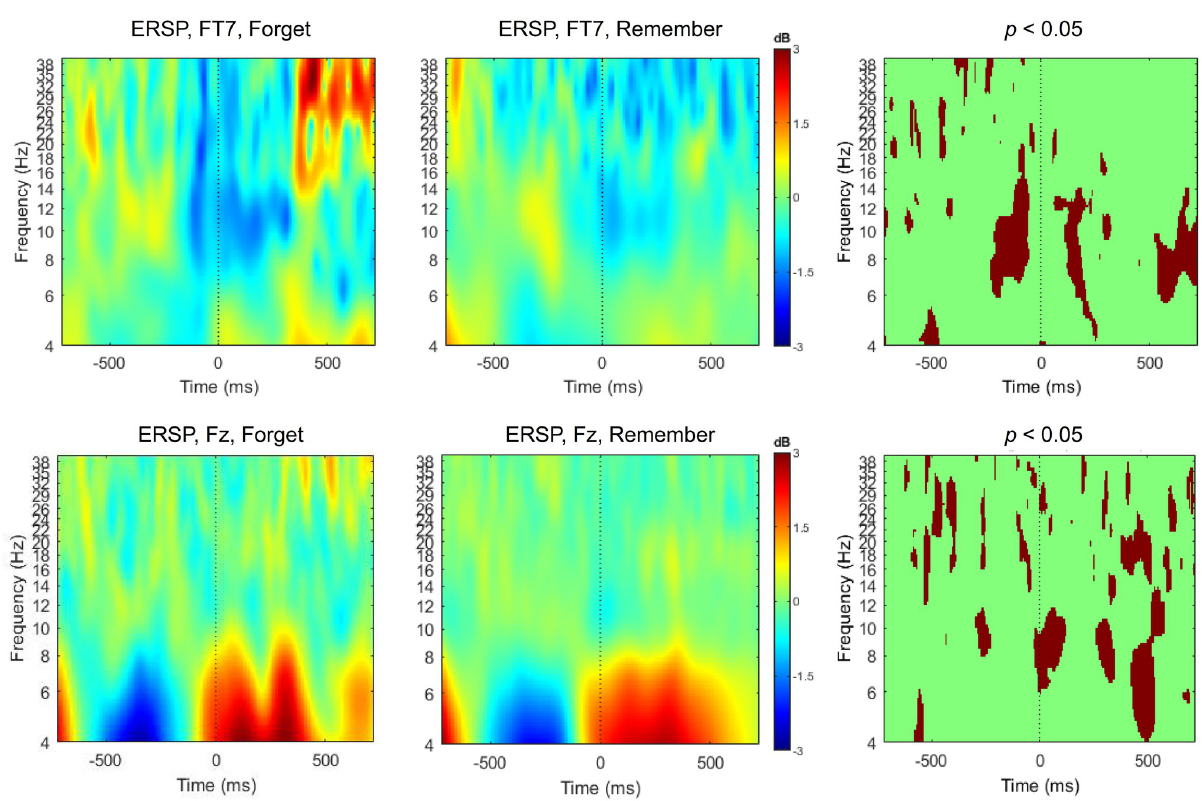
Fig 4. ERSP (event-related spectral perturbation) and statistical results of comparing surface potentials between later remembered items and forgotten items during encoding task for channel FT7 and Fz. Signals were separated per conditions and time-frequency analysis was performed. Statistical analysis revealed differences between conditions ( � p < 0.05 with Bonferroni